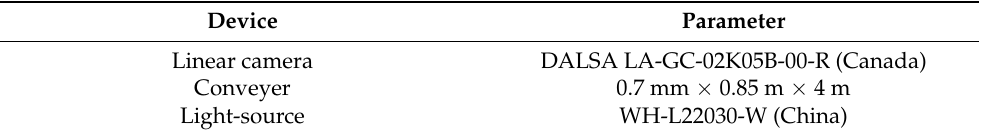
Figure 1. Solid wood floor surface image acquisition equipment. Table 1. Specific parameters or models used in the image acquisition system.